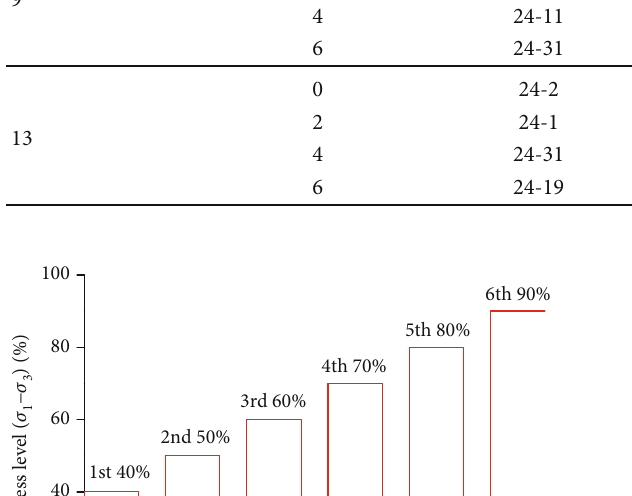
freeze-thaw cycles under di ff erent con fi ning pressure condi- tions was fi tted (Figure 8). The coe ffi cients of determination ( R 2 ) of the fi tted curves were all higher than 0.95. The fi tting results are expressed in Equation (1). The triaxial compres- sive strength of the rock decreased exponentially with an increase in the number of freeze-thaw cycles under di ff erent con fi ning pressures.